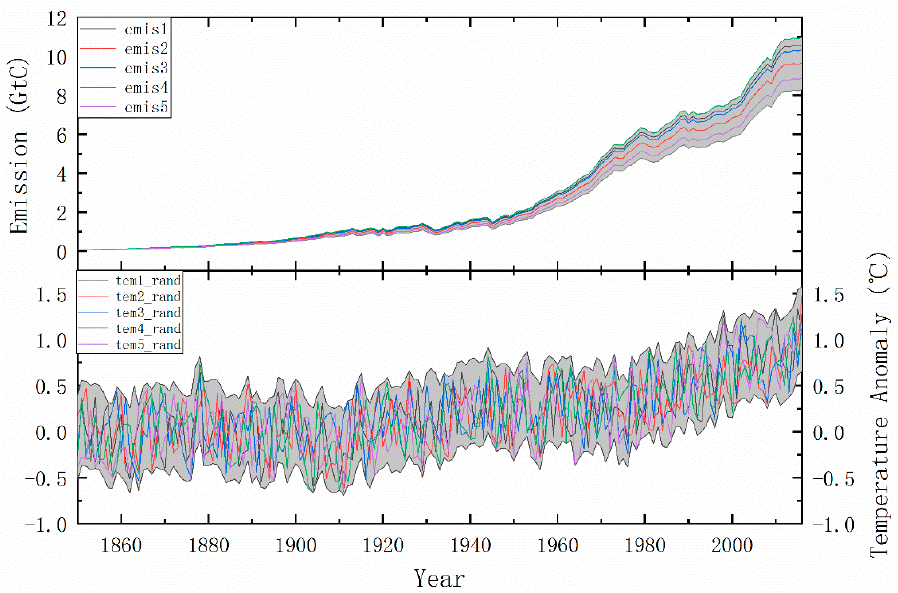
Figure 3. Random inputs of emission and temperature with grey shaded areas showing the uncertainty range.